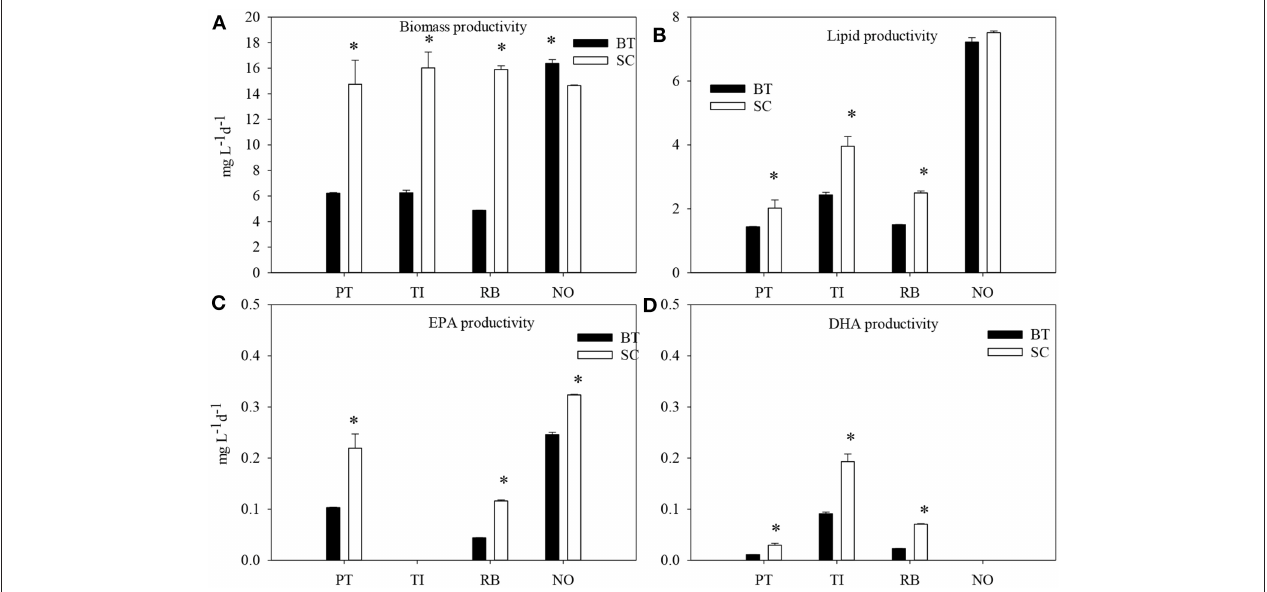
FIGURE 3 | The biomass productivity (A) lipid productivity (B) , EPA productivity (C) and DHA productivity (D) of four marine microalgae species cultured under nitrogen limitation, by batch (BT) and semi-continuous culture (SC). PT, P. tricornutum ; TI, Isochrysis aff. galbana clone T-Iso; RB, R. baltica ; NO, N. oceanica. Mean values with SE bars. t -test were carried out for productivity between BT and SC in the same species. Asterisks indicate significant